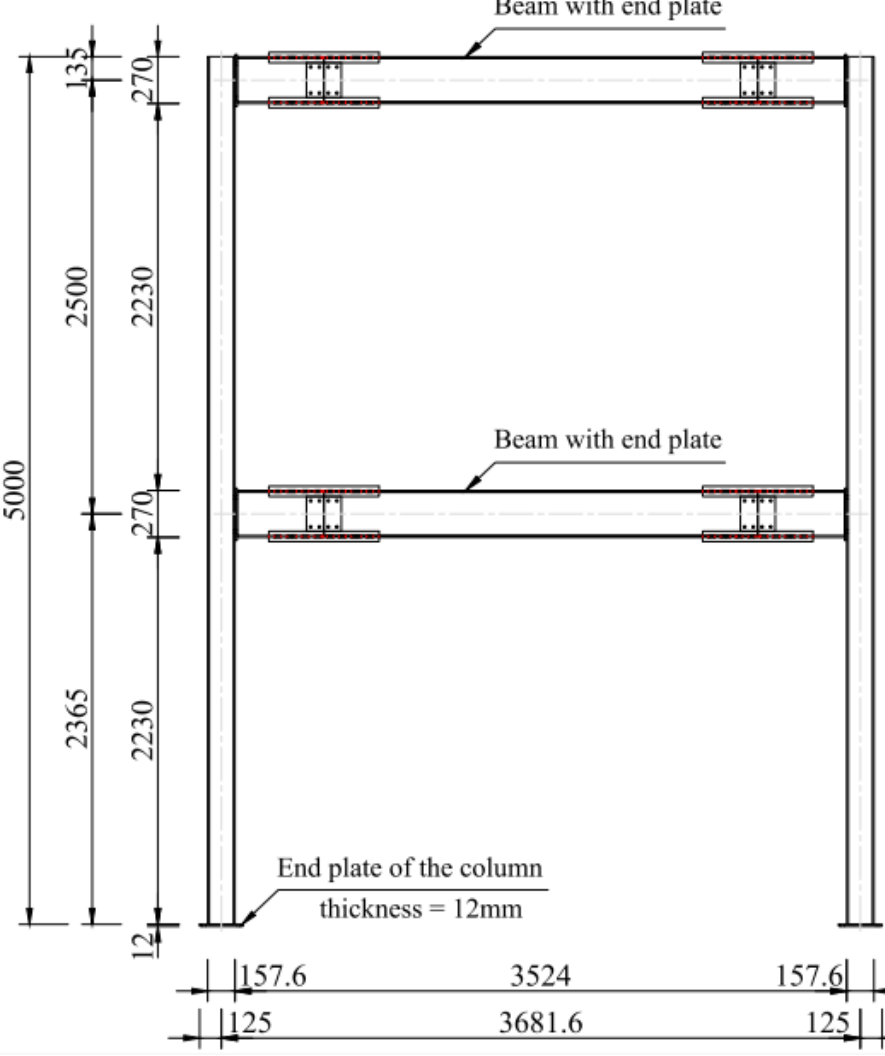
Figure 15. Test frame general arrangement.